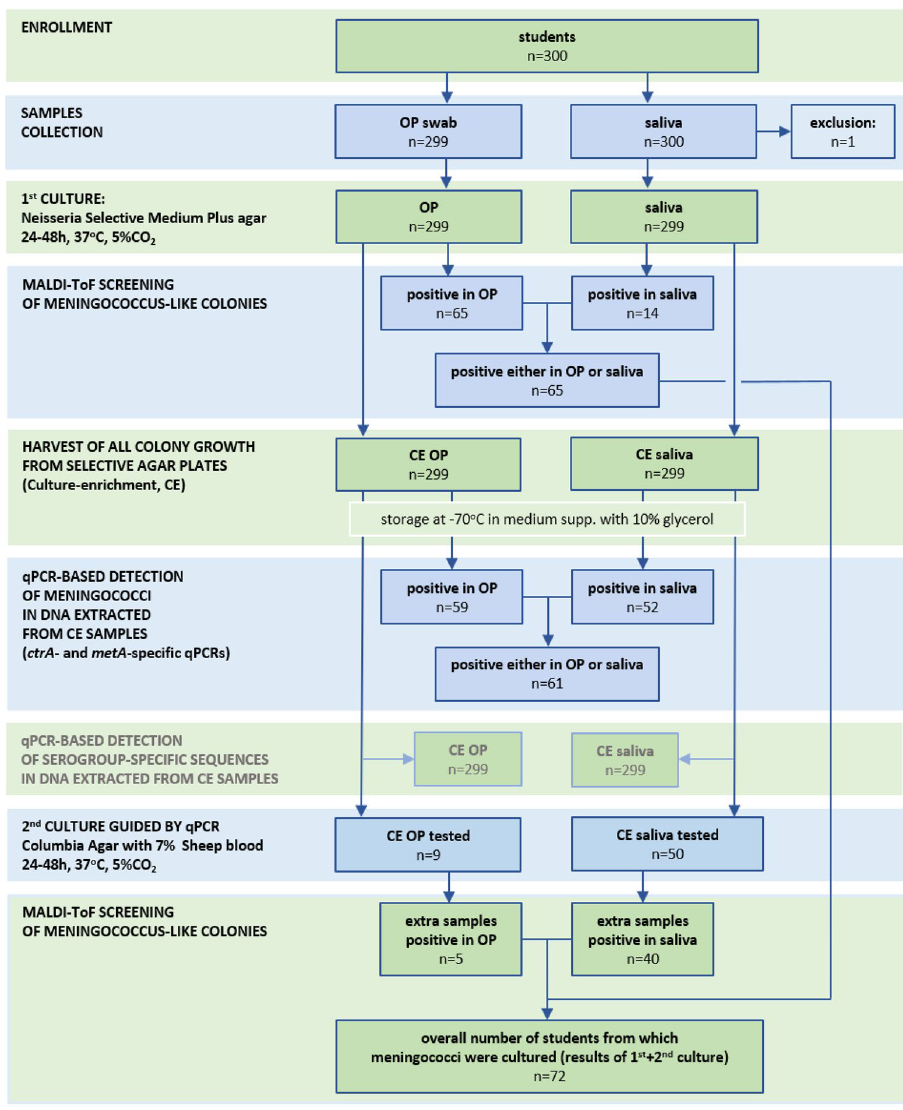
Figure 1. Flowchart depicting the study workflow and results of meningococcal detection using either culture- based or qPCR-based diagnostic methods. OP oropharyngeal sample, CE culture-enriched